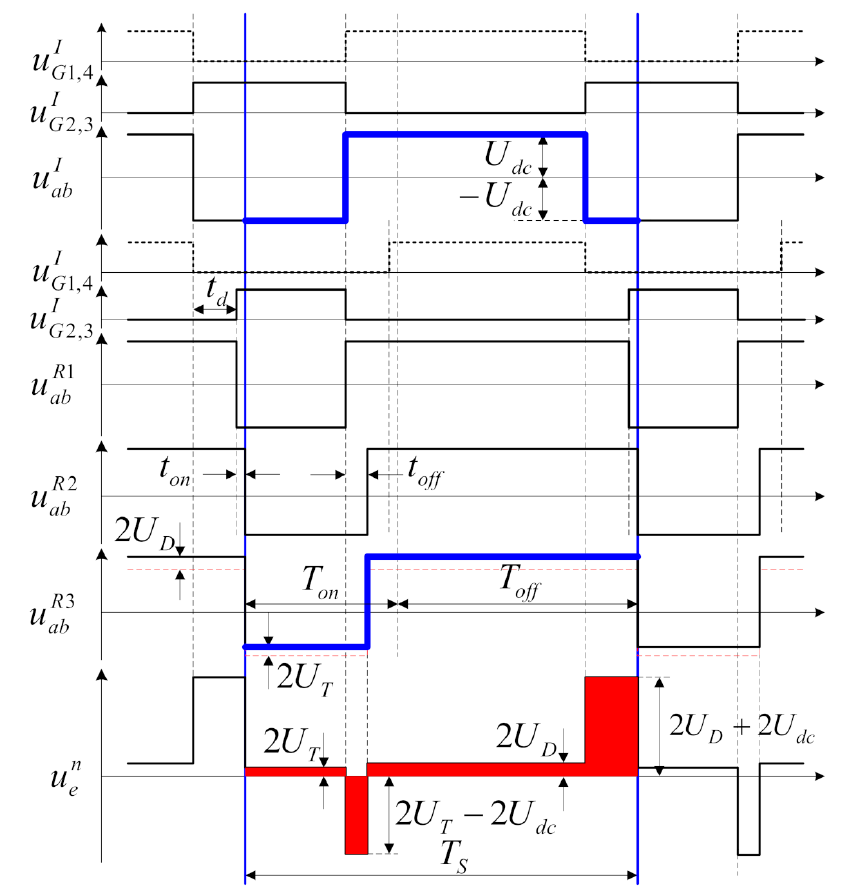
Figure 6. The gate signals waveform, output voltage waveform of the grid-connected converter and error voltage waveform for i inv <